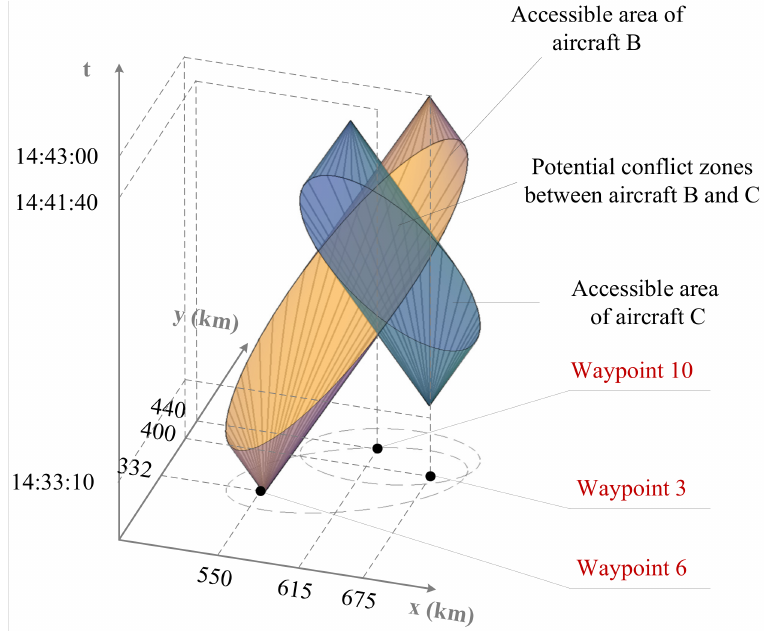
Figure 9. Conflict diagram of aircraft B and